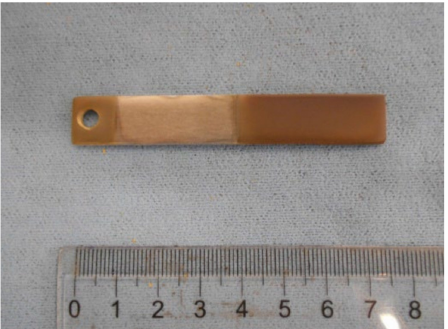
Figure 2. Substrate # 2 with AlN film magnetron sputtered. Moving from right to left: the film is deposited for a length of 35 mm; the following 30 mm were masked, and in the figure the aluminum substrate without film deposition is visible; finally, the film is on the last 10 mm (where a hole is present for connection).